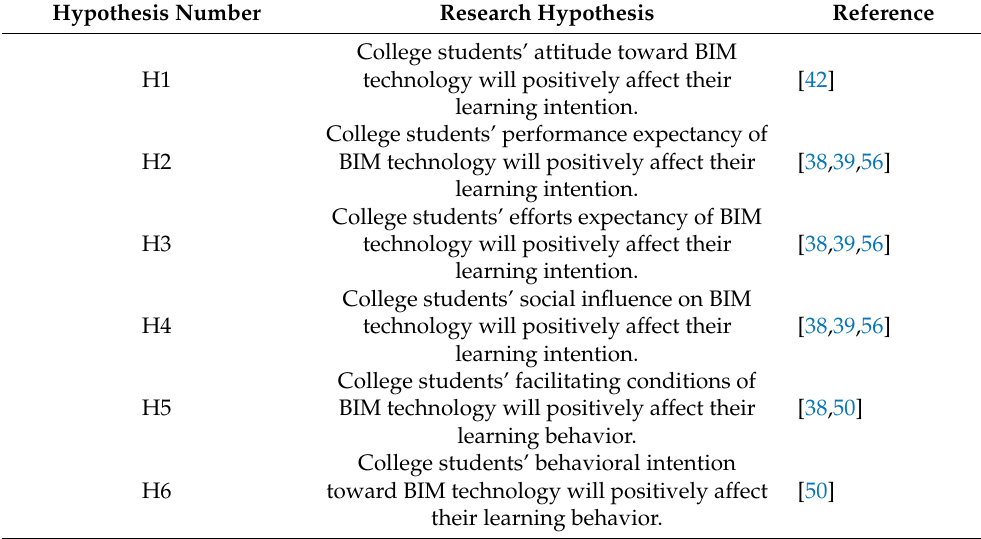
Table 1. Research